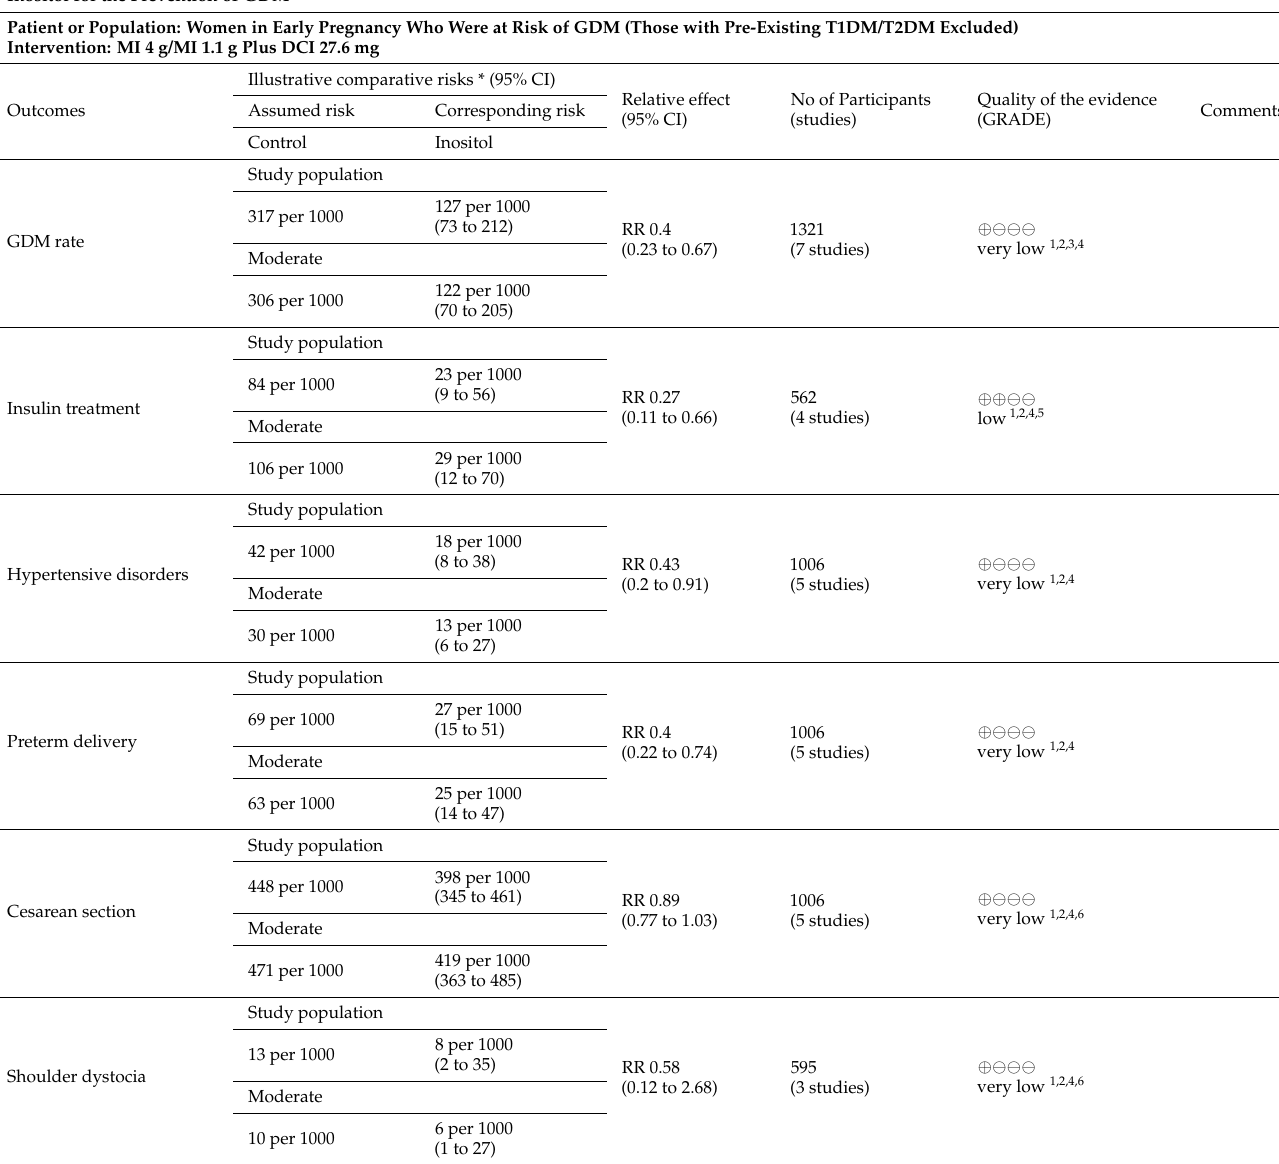
Table 2. Summary of finding: inositol for the prevention of